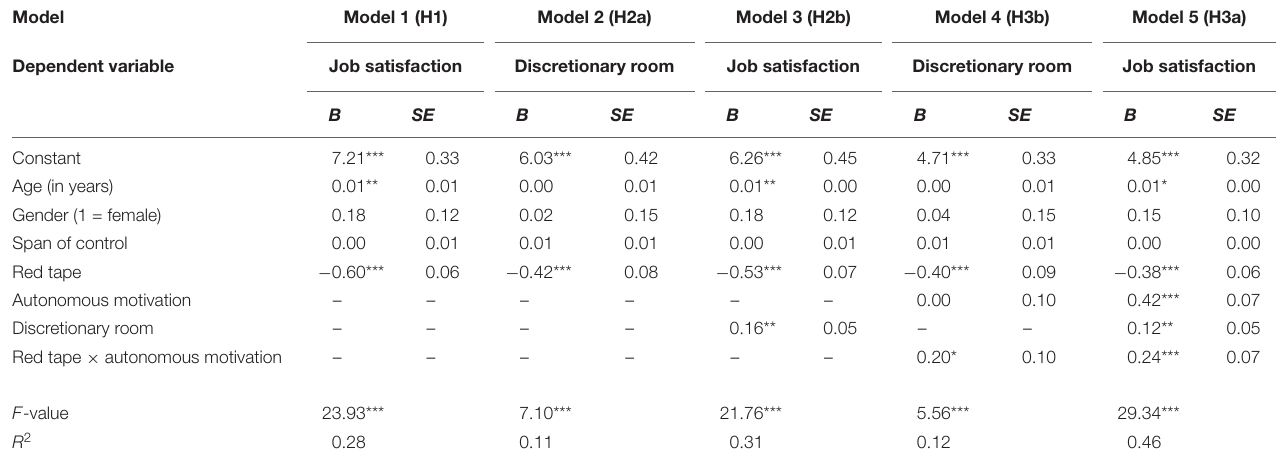
TABLE 3 | Regression results.